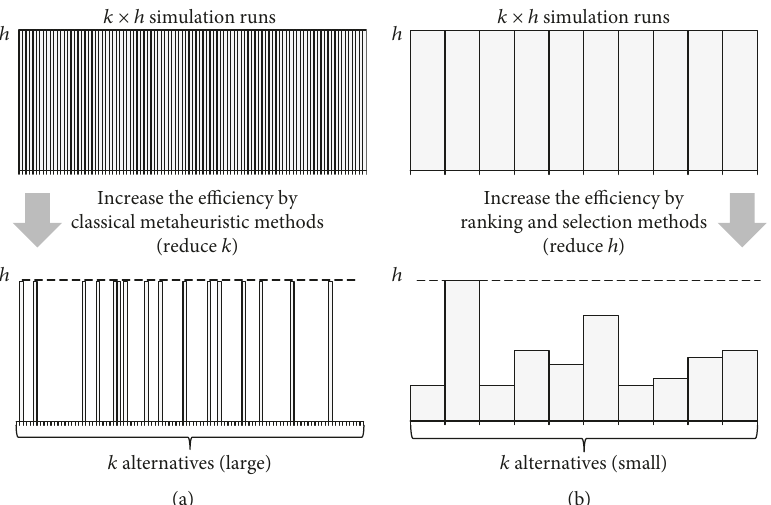
Figure 3: Various approaches for increasing the e ffi ciency of the optimization in the stochastic simulation model: (a) classical metaheuristic methods and (b) R&S methods.